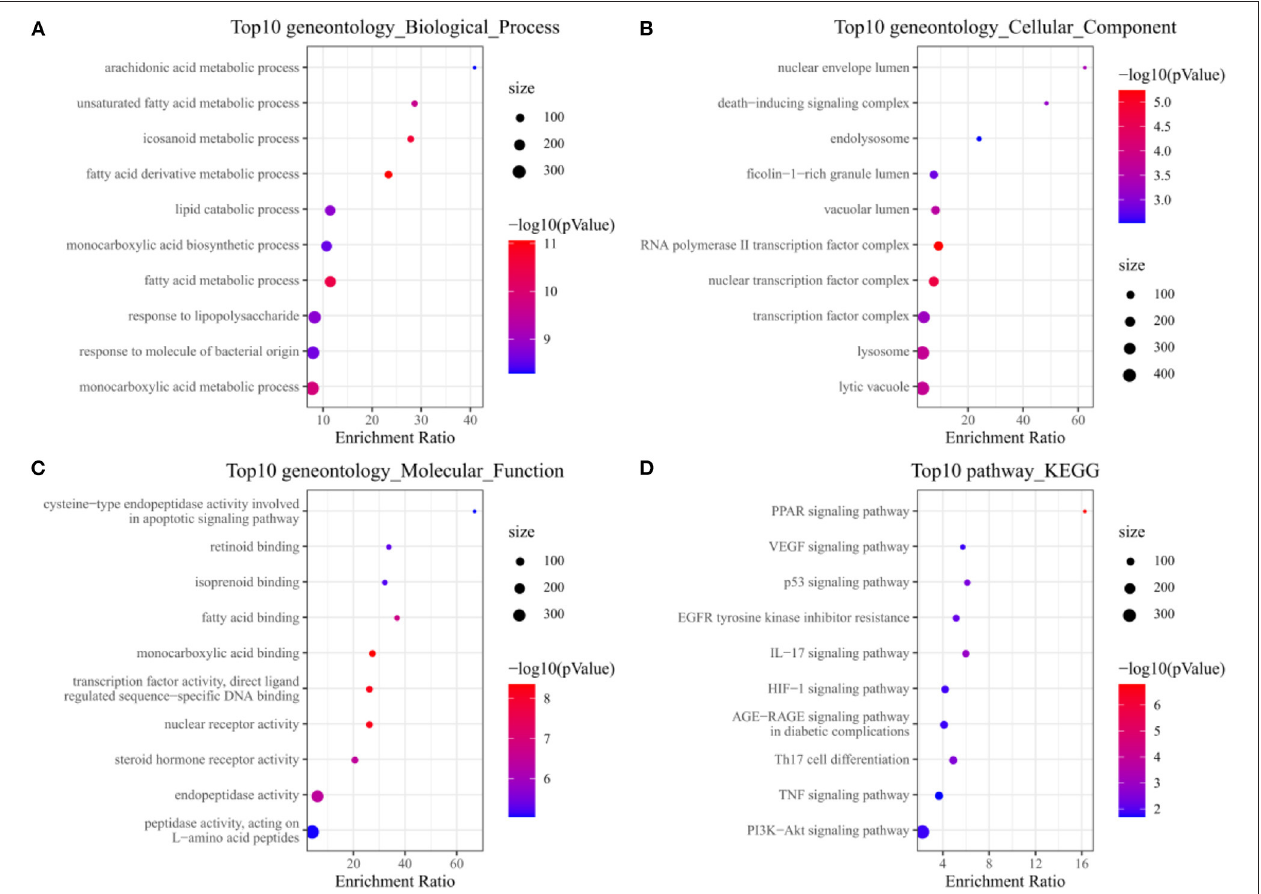
algorithm to screen these 63 intersecting targets with their respective mutual. The linked targets are called protein groups ( Supplementary Material 2 ). These screened protein